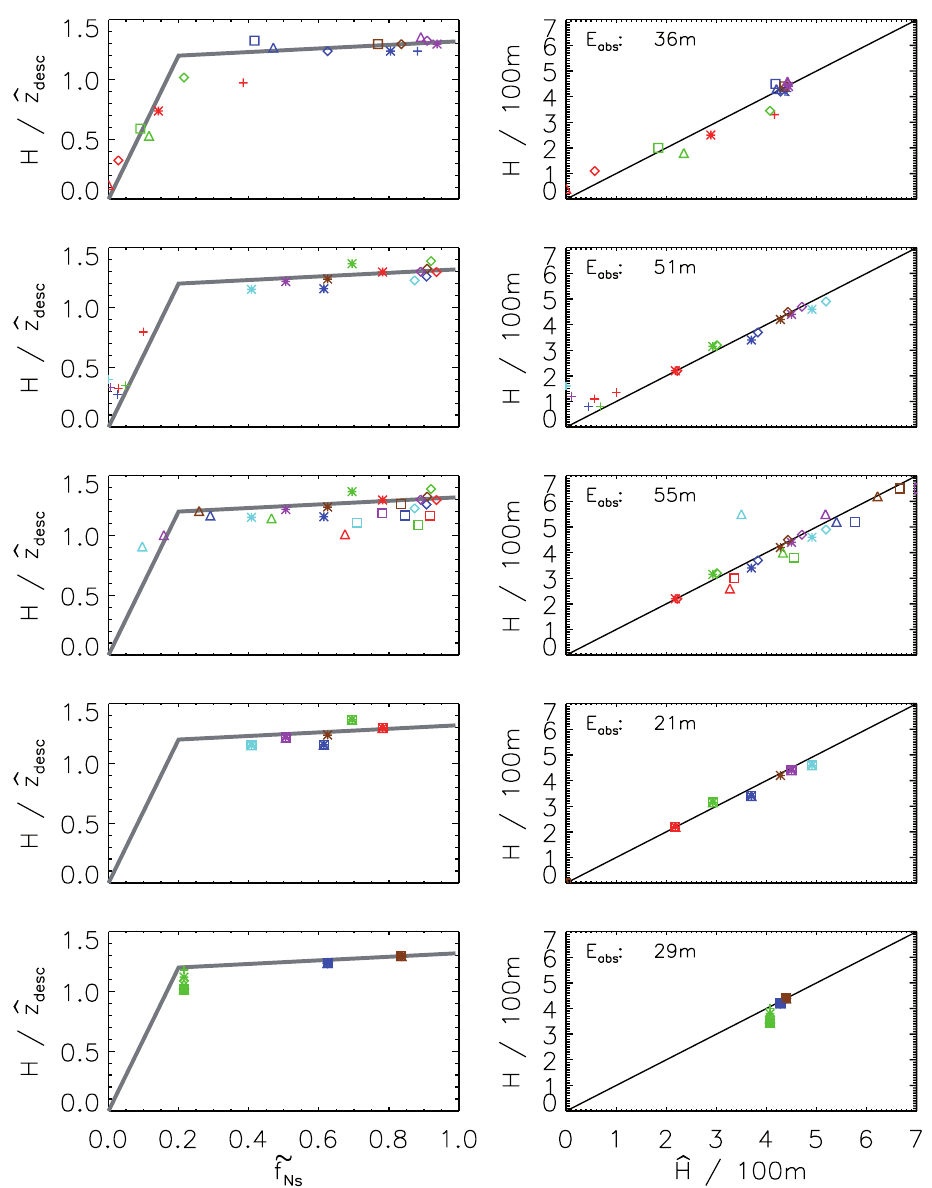
Figure 6. Left: relationship between simulated contrail depth H over approximated ˆ z desc and approximated survival fraction e f Ns . The grey curve shows the fit function ˆ b as defined in Eq. (13). Right: relationship between simulated contrail depth H and approximated contrail depth ˆ H . The root mean square of the absolute error ˆ H − H is denoted as E abs and given for each subset. The simulation subsets and the layout are analogous to Fig.